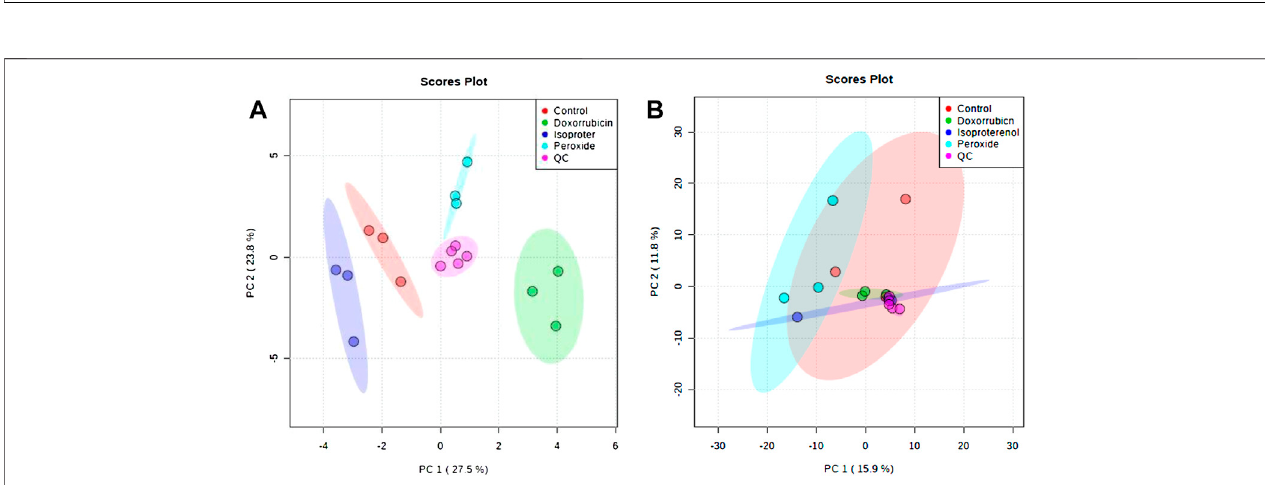
FIGURE2| PCAplotsgeneratedusingallsamplesandQCanalysesbyCE-MSinthepositiveionizationmode. (A) Extractobtainedfromcellsand (B) Supernatant obtained from cell culture medium.